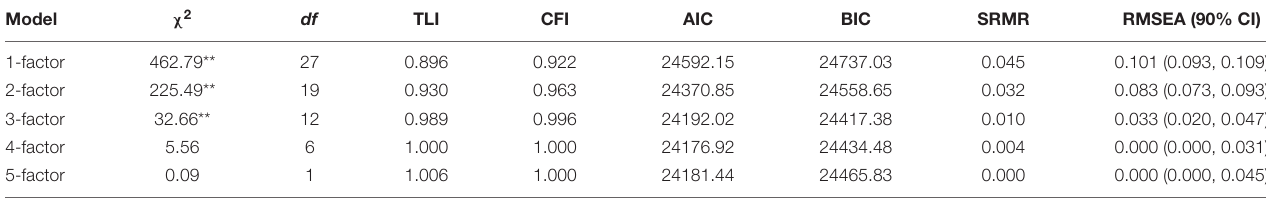
TABLE 2 | Exploratory factor analysis model-data fit indexes for RT data.